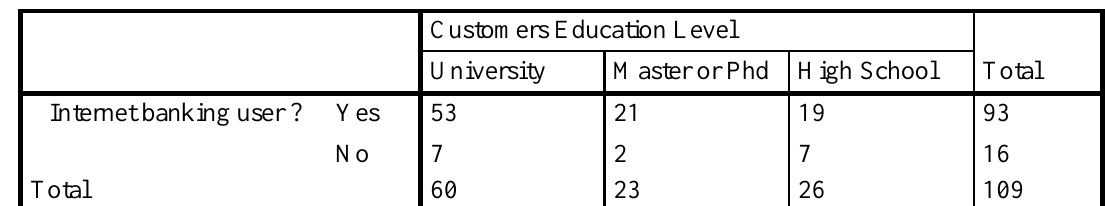
Table 6. Internet banking users vs. education level crosstabulation Crosstab